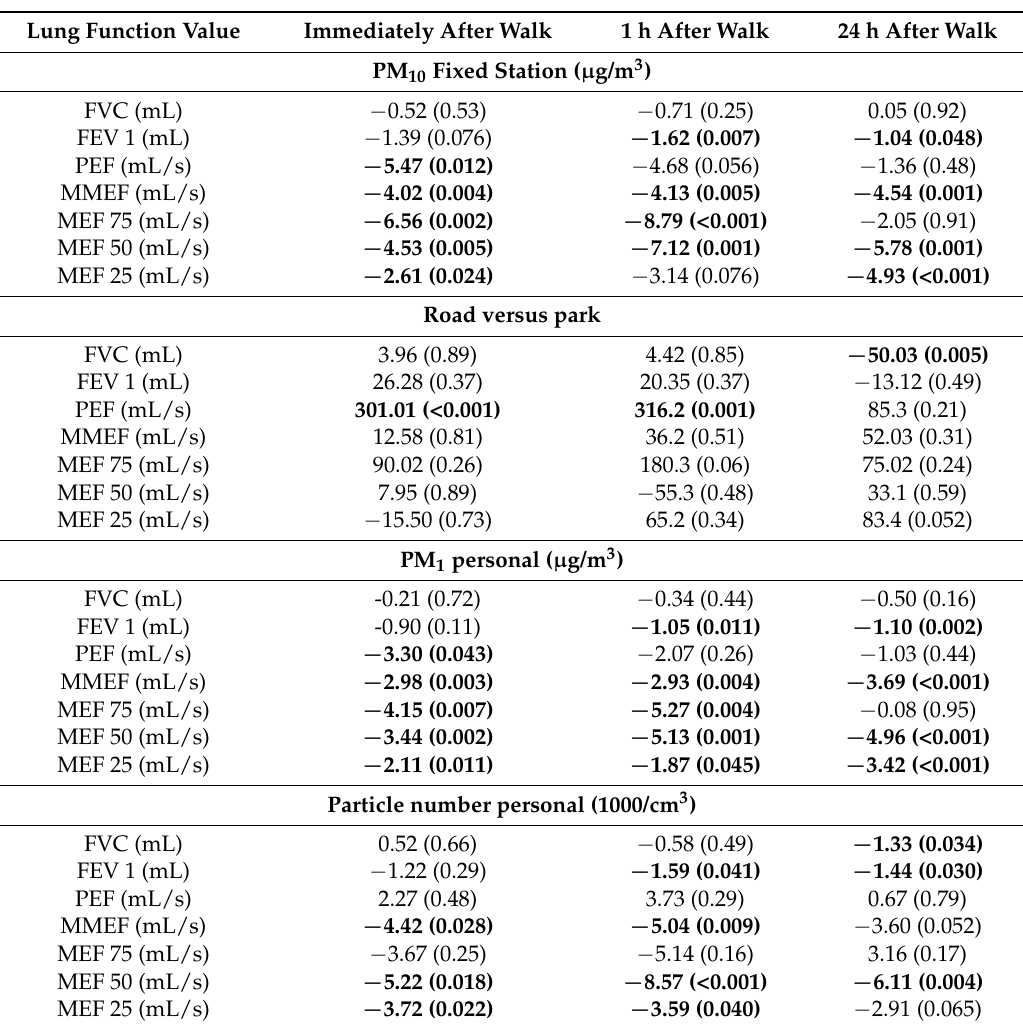
Table A1. Unadjusted effect estimates ( p -value): lung function change per 1 µ g/m 3 (personal PM 1 , central monitor PM 10 ), per 1000 particles per cm 3 , and road vs. park. The latter independent parameter is combined in one model with PM 10 from the central monitor. ( bold: p < 0.05